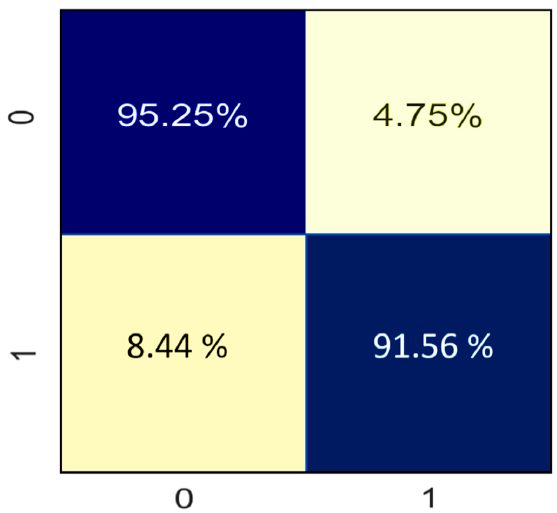
Figure 16. Confusion matrix of proposed theft-detection model.